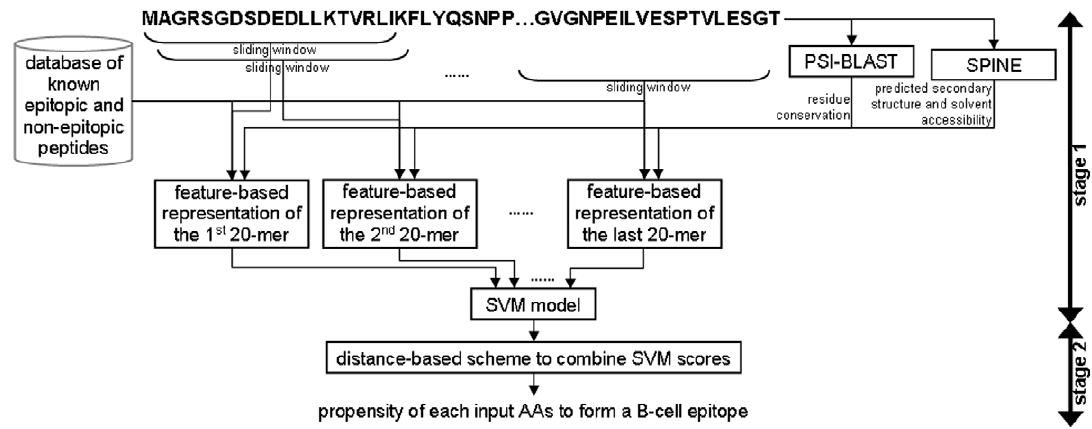
Figure 1. Overall design of the proposed BEST method.